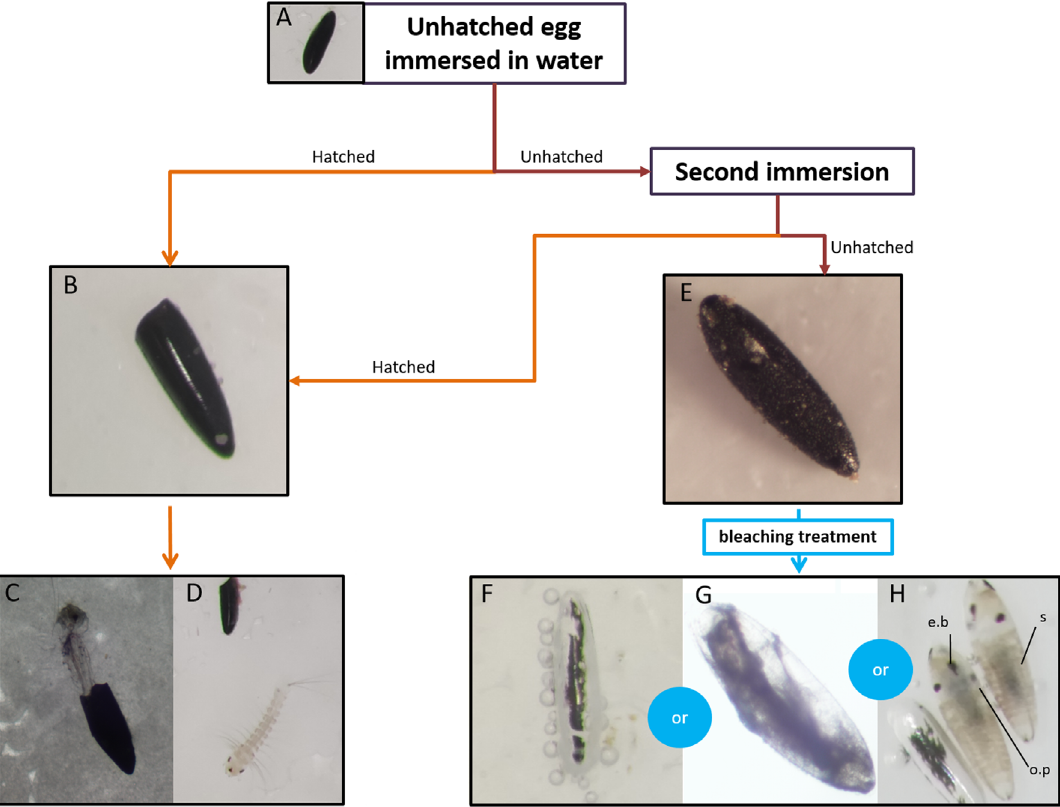
Figure 2. Assessment of hatching success, mortality rate and diapause incidence. Eggs (A) are immersed in tap water twice. After this hatching test, eggs can either hatch (orange arrows – B), resulting in a larva (C and D) out of the shell, or remain unhatched (red arrows – E), meaning the egg has not opened. Afterwards, unhatched eggs are bleached (blue arrows). In this case, unhatched eggs can either be unfertilised (F), partially embryonated (G) or contain a fully developed embryo (H). Full embryogenesis is achieved when complete segmentation (s), pigmented ocelli (o.p) and egg burster (e.b) are observed without